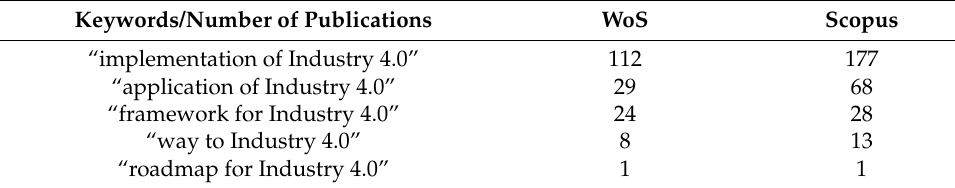
Table 1. Results of own literature review in the field: number of publication.